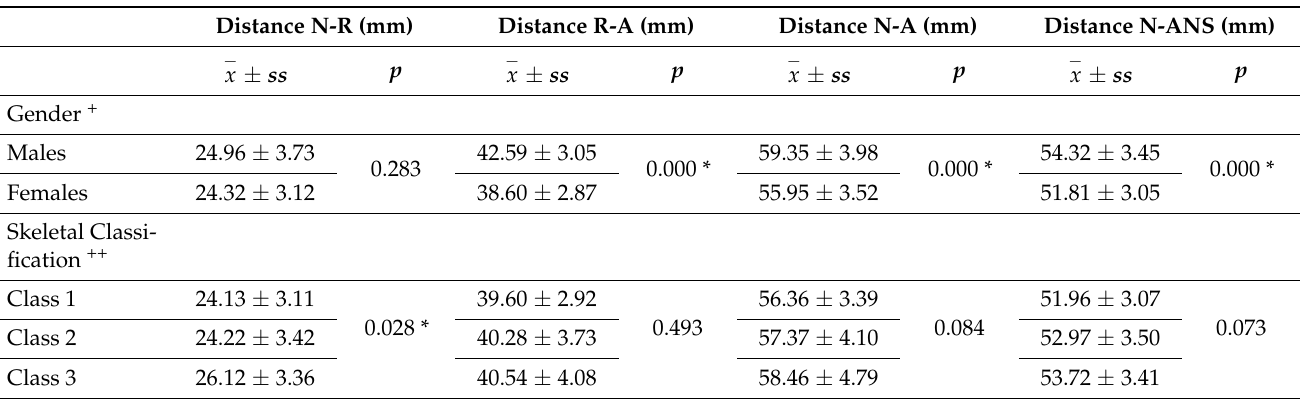
Table 3. Comparison of nasal parameters between the